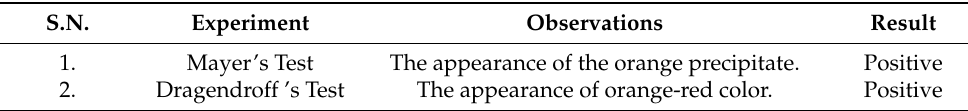
Table 2. Confirmatory test for Coriaria nepalensis stem alkaloids. S.N. Experiment Observations Result 1. Mayer’s Test The appearance of the orange precipitate. Positive 2. Dragendroff ’s Test The appearance of orange-red color.